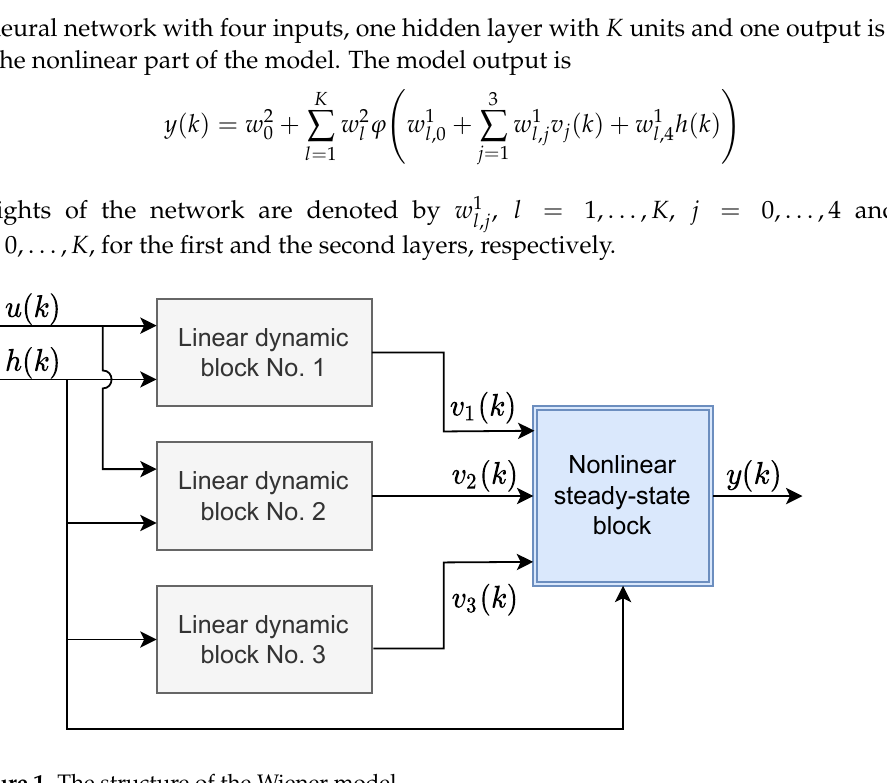
Figure 1. The structure of the Wiener